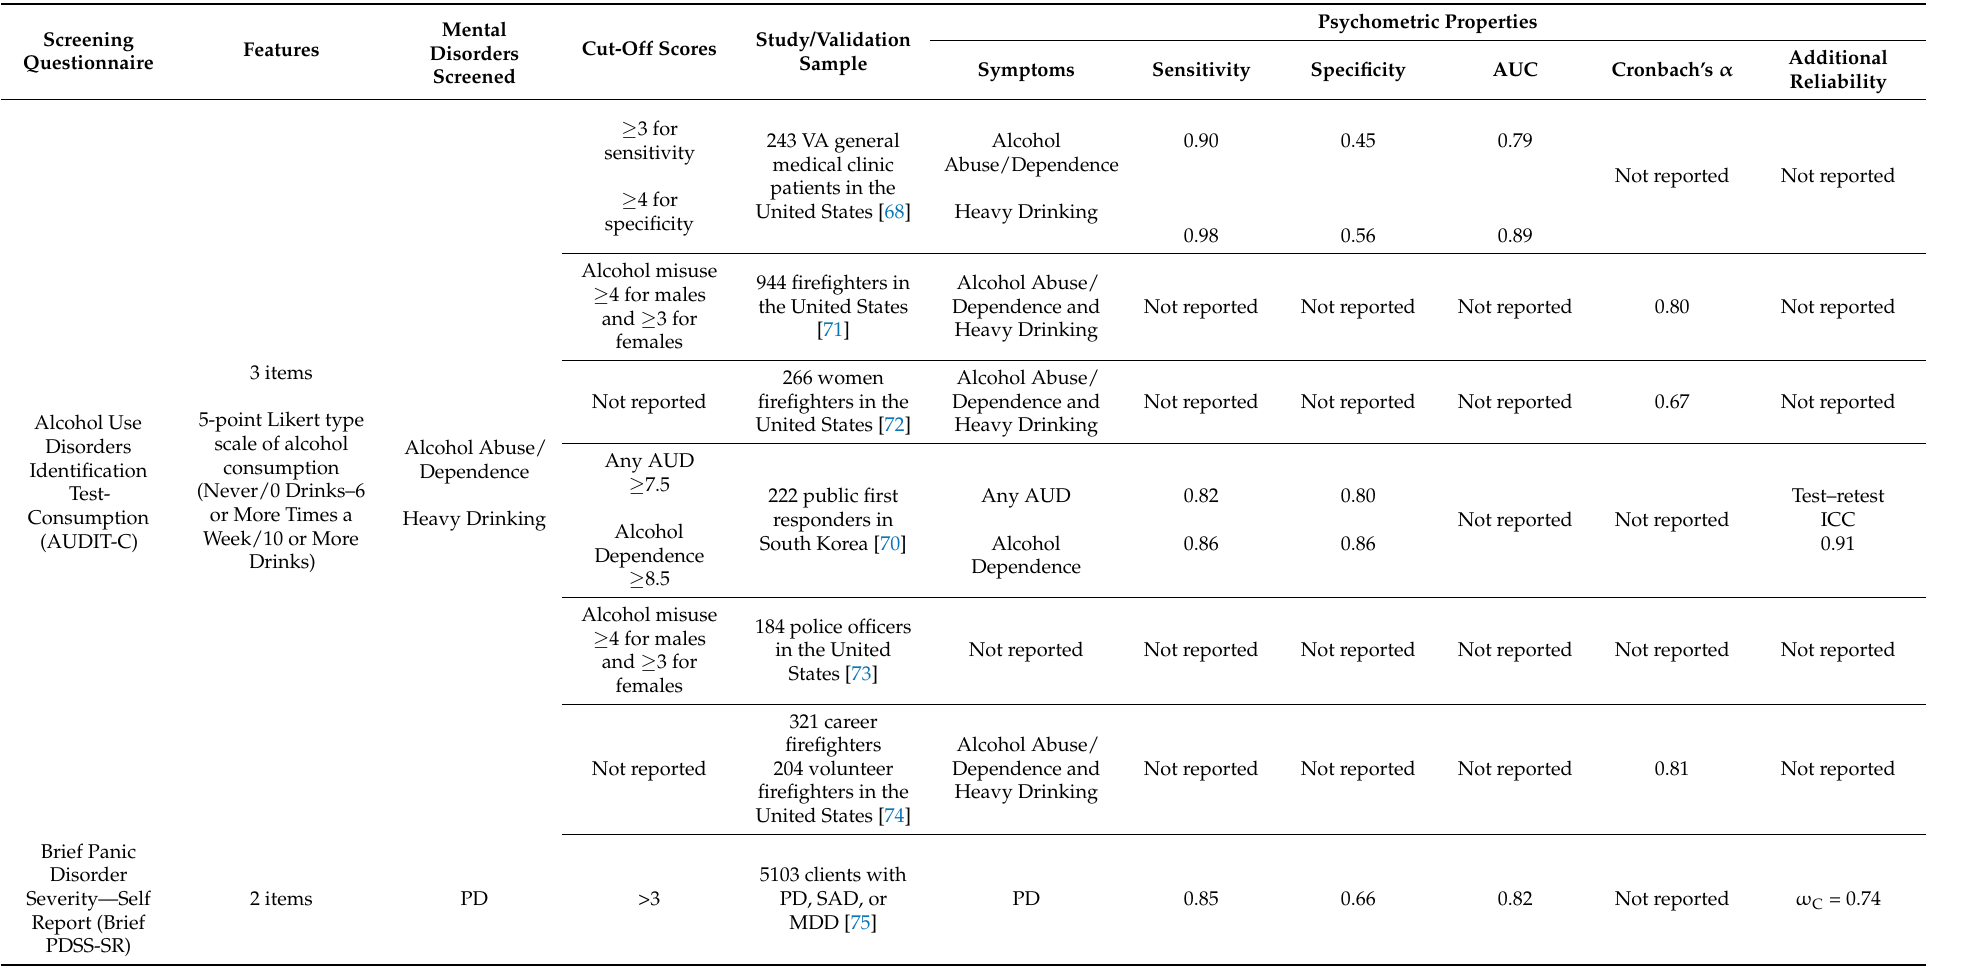
Table 2. Features and Empirical Evidence of Brief Mental Disorder Screening Questionnaires (Single-Disorder Symptom